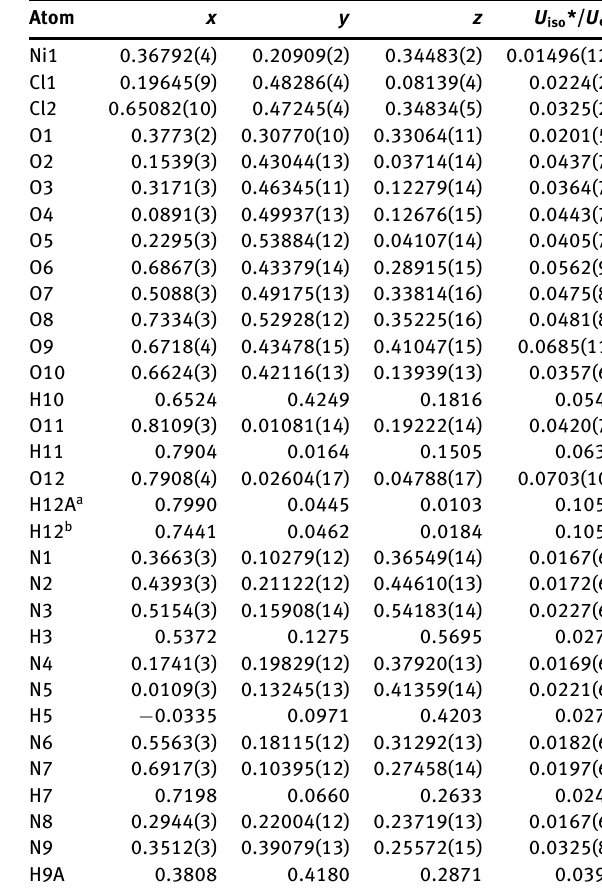
Table 2: Fractional atomic coordinates and isotropic or equivalent isotropic displacement parameters (Å 2